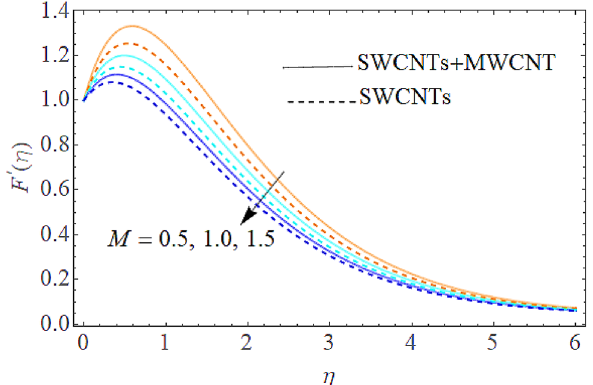
Figure 4. Outcome of M on F ′ (η) .